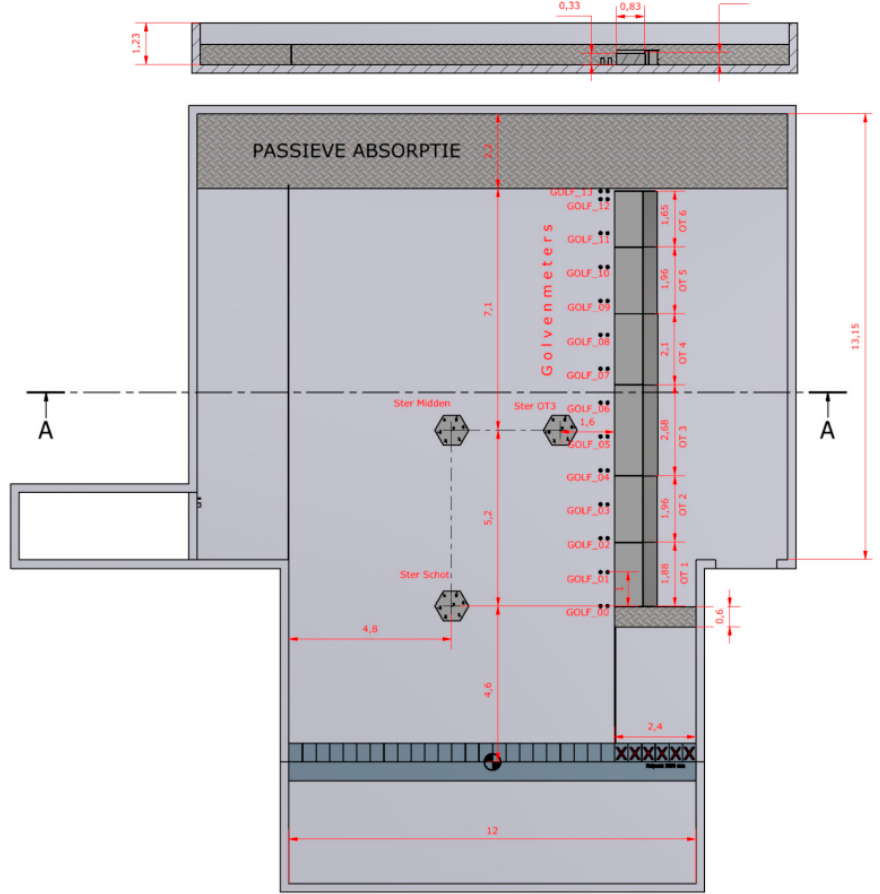
Figure 2. Plan and cross-sectional view of the physical model in the multi-directional wave basin (reproduced from Willems et al. [16] .) ‘GOLF’ stands for wave gauge, and the decimal signs here are expressed as ‘,’ instead of ‘.’ (e.g., ‘4,8’ is ‘4.8’) Table 1. Data for the validation cases (prototype scale). Case names starting with D are from Dan et al., and those starting with W are from Willems et al.